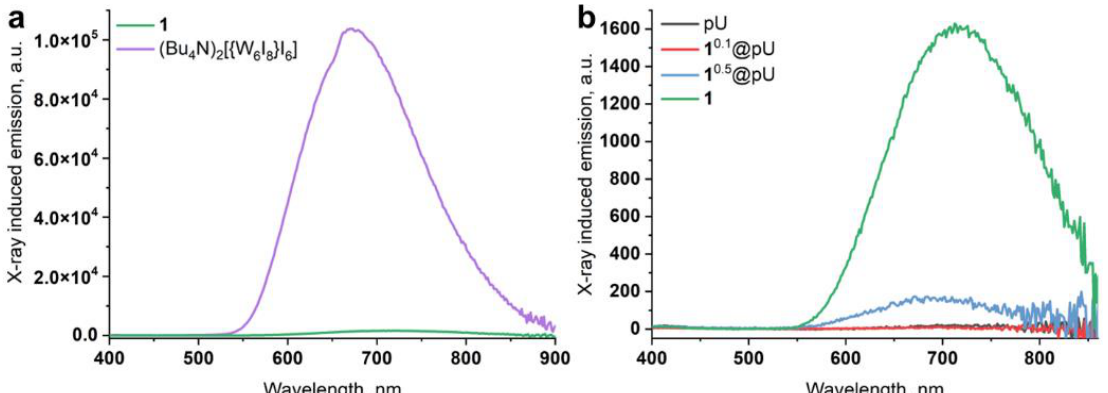
Figure 6. XEOL spectra for: ( a ) cluster 1 and (Bu 4 N) 2 [{W 6 I 8 }I 6 ]; and ( b ) cluster 1 , pure pU nanoparti- cles, and 1 0.1 @pU and 1 0.5 @pU samples. Each line is an average from three scans lasting 18 min each. Cluster 1 is added to both pictures to facilitate the comparison.